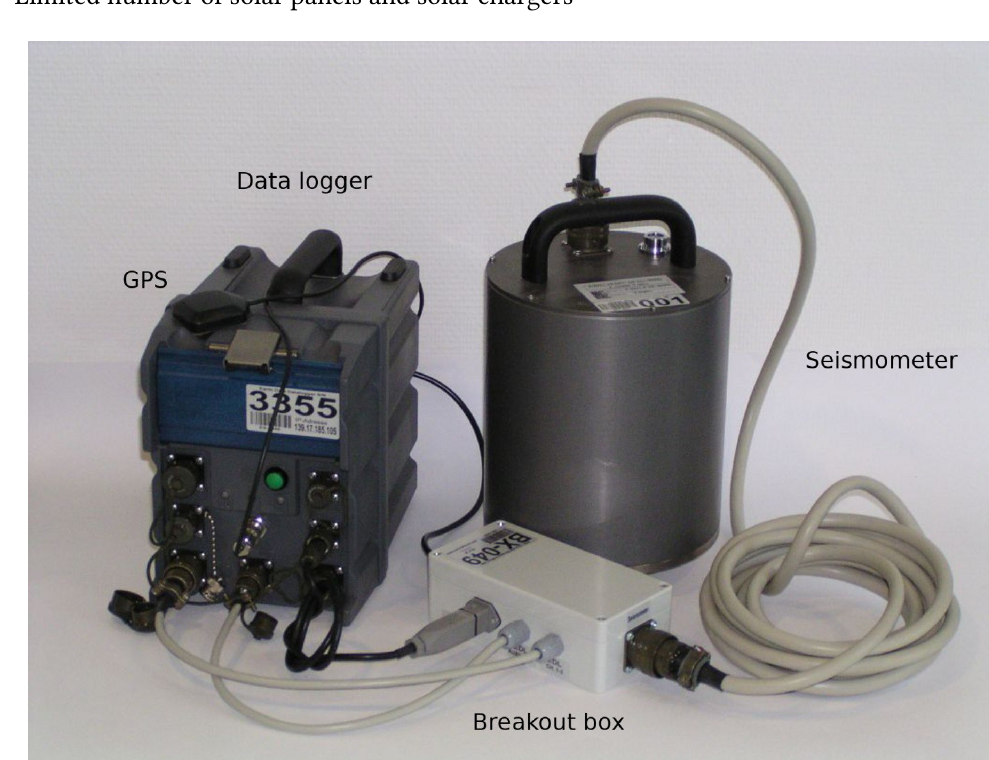
Figure 2: DEPAS onshore station assembled in the lab without outdoor casing and power supply. Main components are